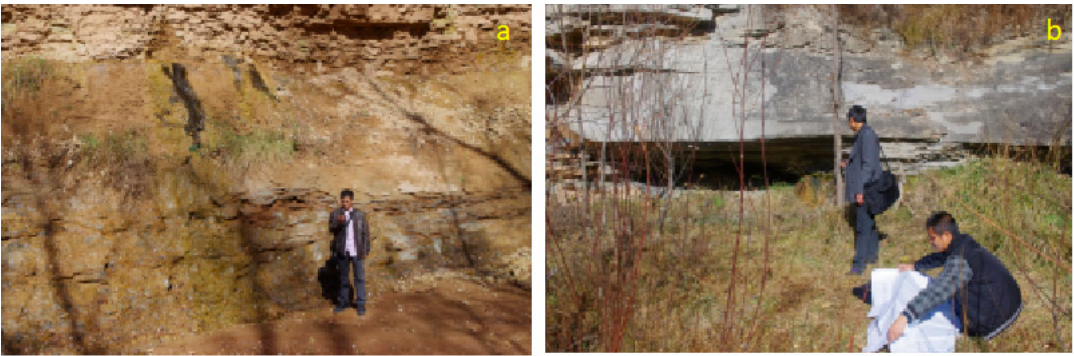
Figure 3. ( a , b ) Process of identifying spring locations in the field.